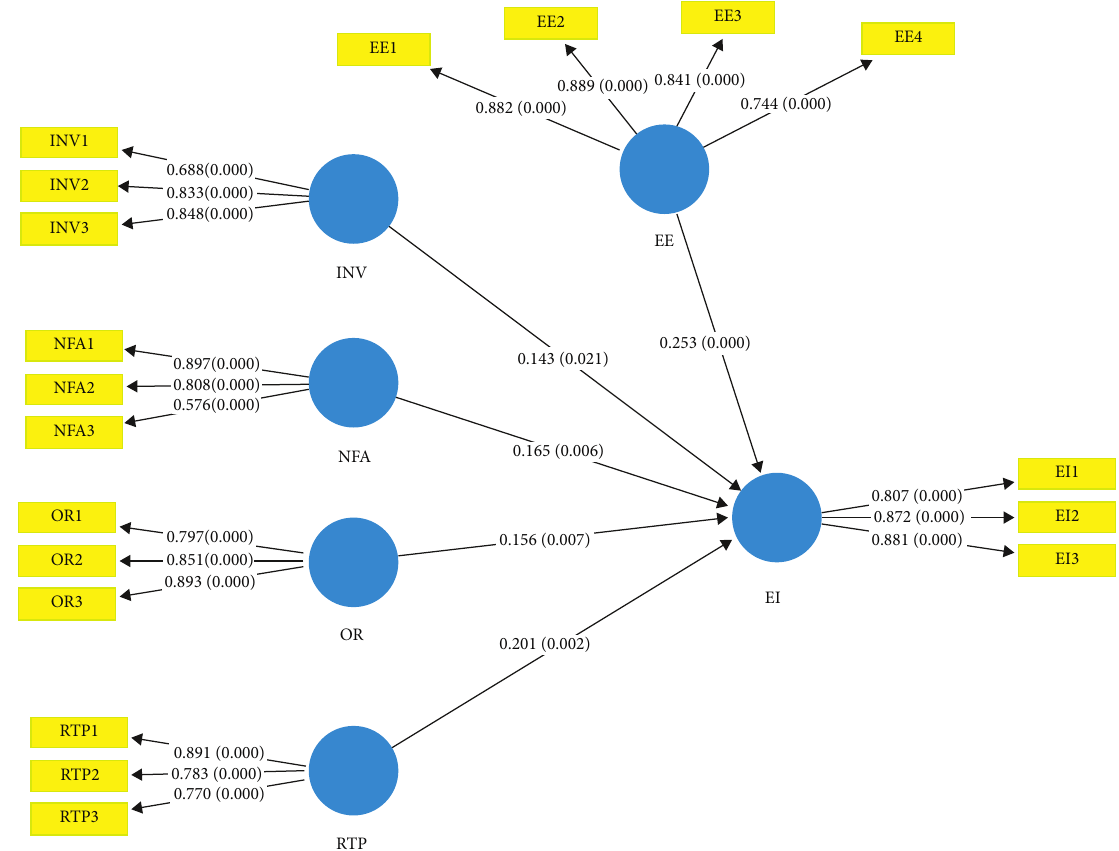
Figure 2: Graphical presentation of the Entrepreneurial Intention model understudy. Source: extracted from SmartPLS.